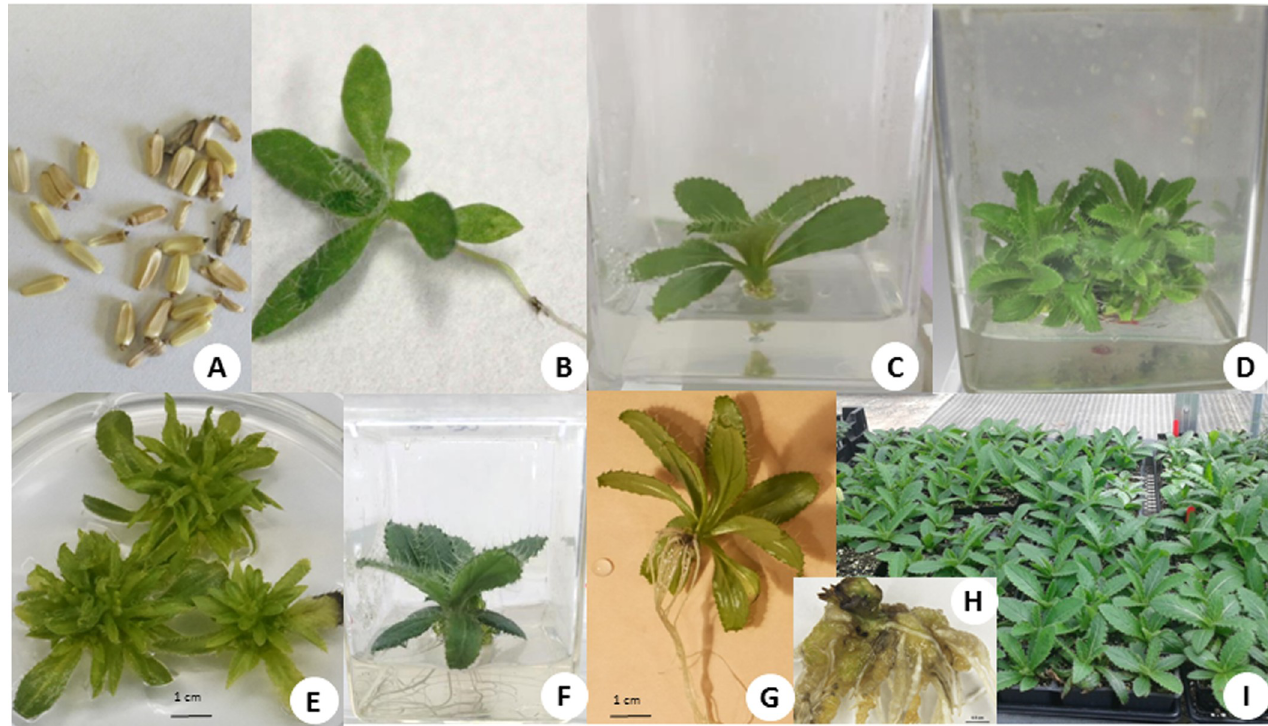
Fig 2. Hill’s thistle Seeds (A) were collected from Parks Canada, Tobermory and germinated under in vitro conditions (B). Three weeks old in vitro shoots (C) were subcultured on the shoot multiplication medium with BA at 5.0 μ M (D) and 10.0 μ M (E) to multiply shoots. In vitro rooting observed when individual shoots were subcultured on the medium without auxin (F), with NAA at 5.0 μ M (G) and 20.0 μ M NAA (H). All rooted plants were acclimatized in the greenhouse conditions (I) before transplanting to their natural habitat.